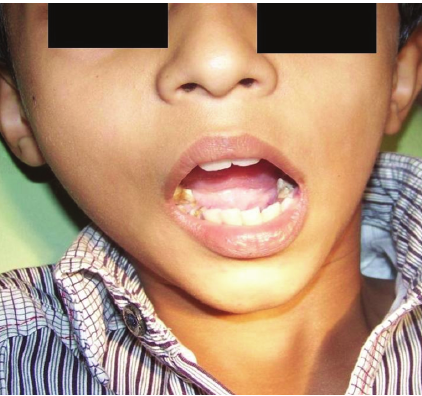
Figure 3: Decreased mouth opening with deviation towards left